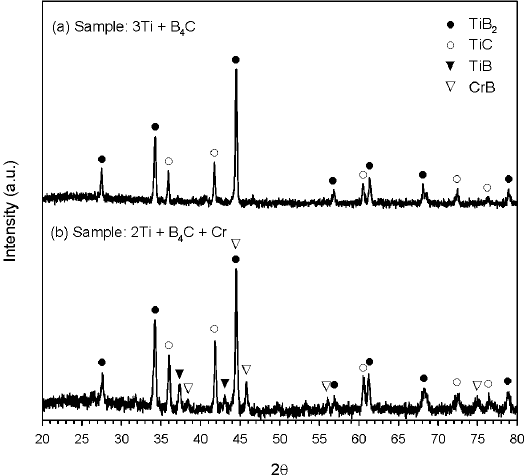
Figure 4. XRD patterns of SHS-derived composites from samples with stoichiomerties of ( a ) 3Ti + B 4 C and ( b ) 2Ti + B 4 C + Cr.